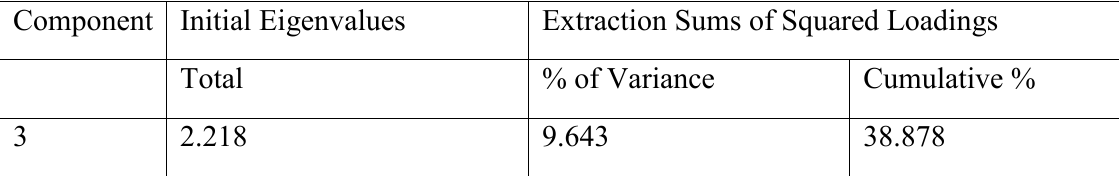
Table 1.43: Variance explained for Transformative Resilience PC3 Component